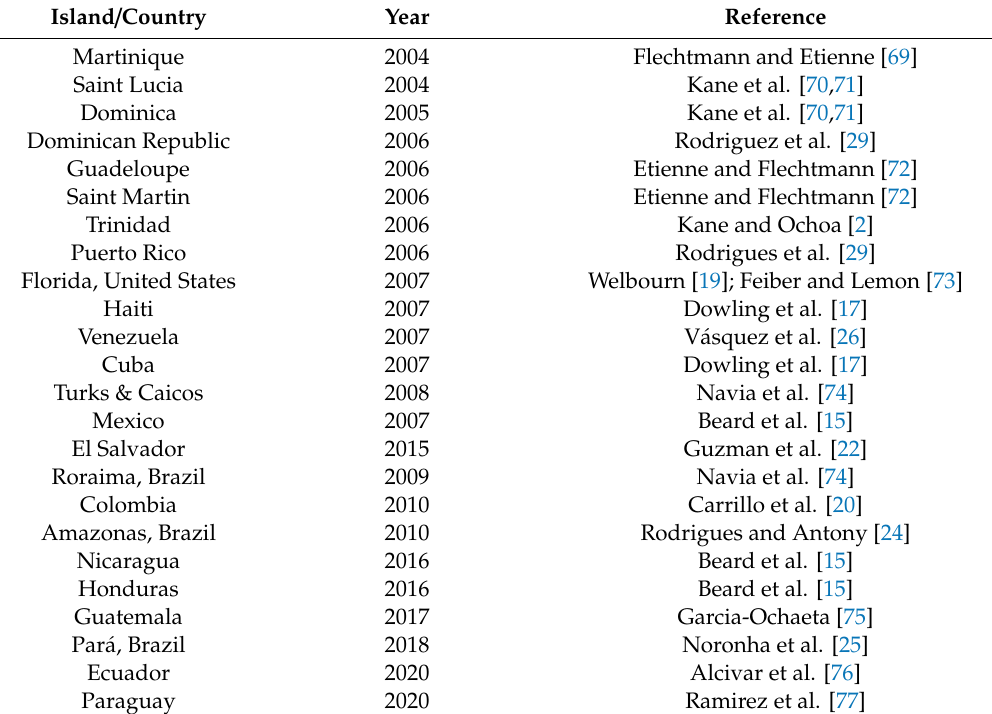
Table A1. Year red palm mite ( Raoiella indica Hirst) was first detected in